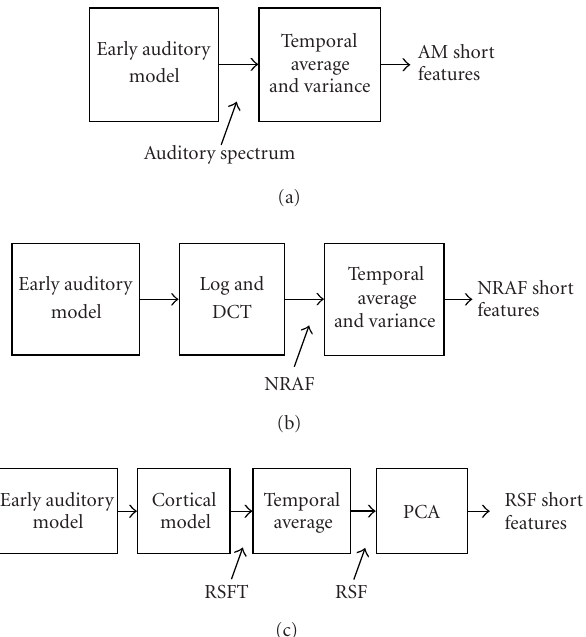
Figure 6: Extraction of the di ff erent features used in the classifica- tion.